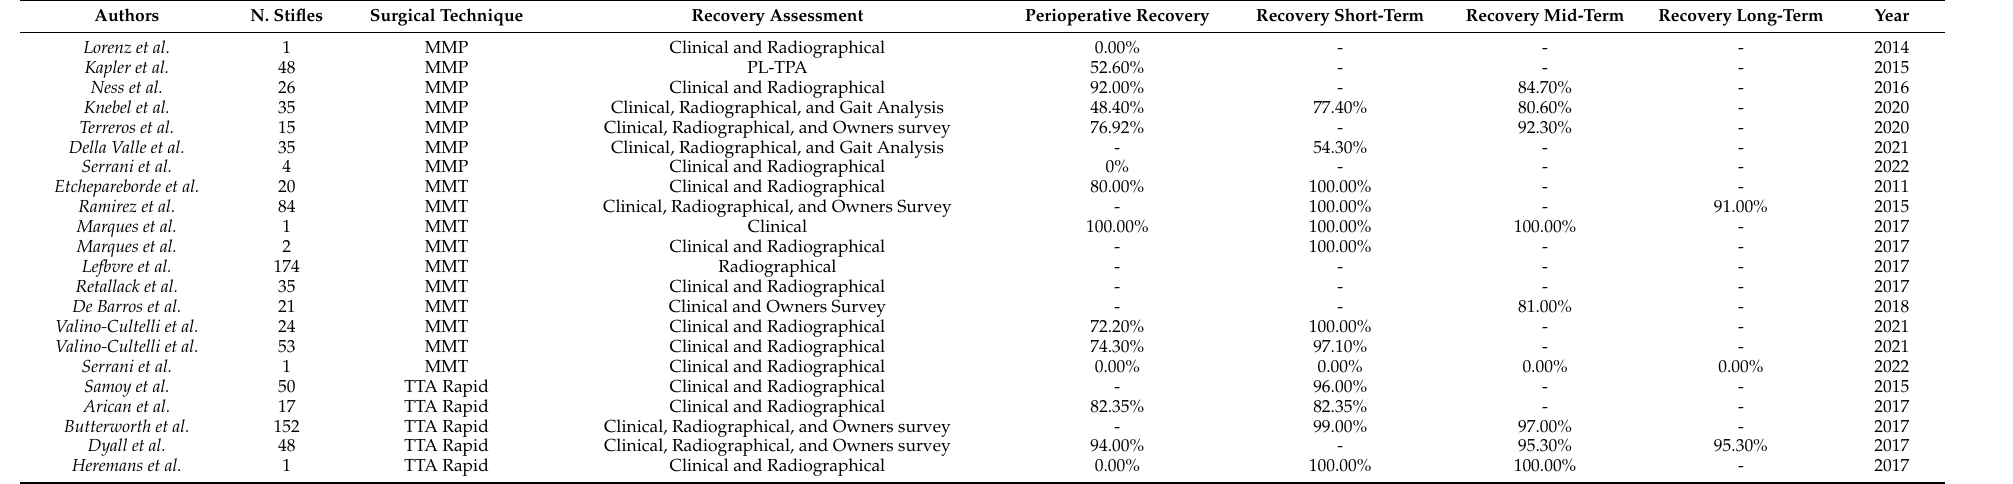
Table 2. The outcome of reviewed papers is divided by surgical technique and time